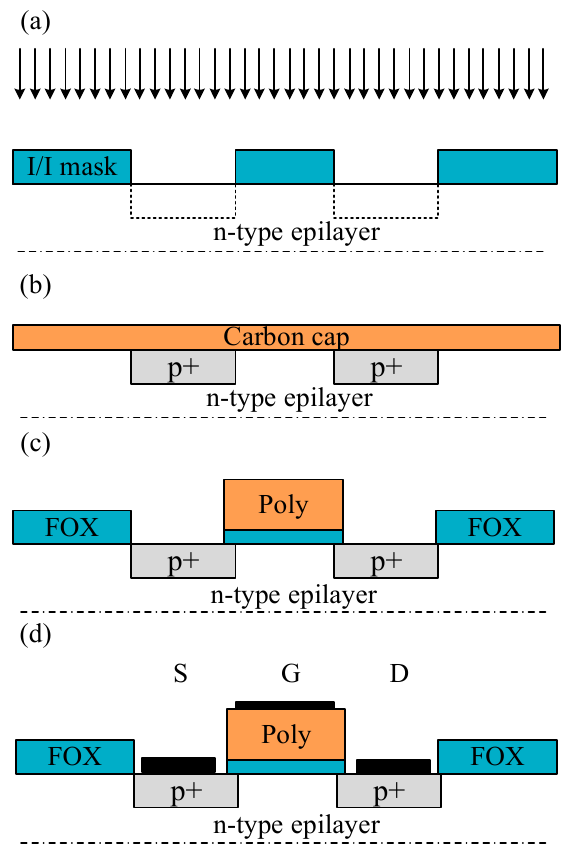
Figure 3. Simplified non-self-aligned SiC metal oxide MOSFET ( a ) Ion implantation of p-type dopants (arrows) into source and drain (dashed boxes) is performed with an ion implant hard mask; ( b ) during ion implantation annealing, the surface has to be protected with a carbon cap, which prevents Si out-diffusion and surface roughening even at 1,800 °C; ( c ) the field oxide (FOX) and polycrystalline silicon gate (poly) stack is aligned with global alignment marks (not shown), and some overlap must be allowed; ( d ) the metal must be patterned before annealing at ~800–900 °C to form the metal silicide (otherwise the reaction will occur with SiO 2 ).